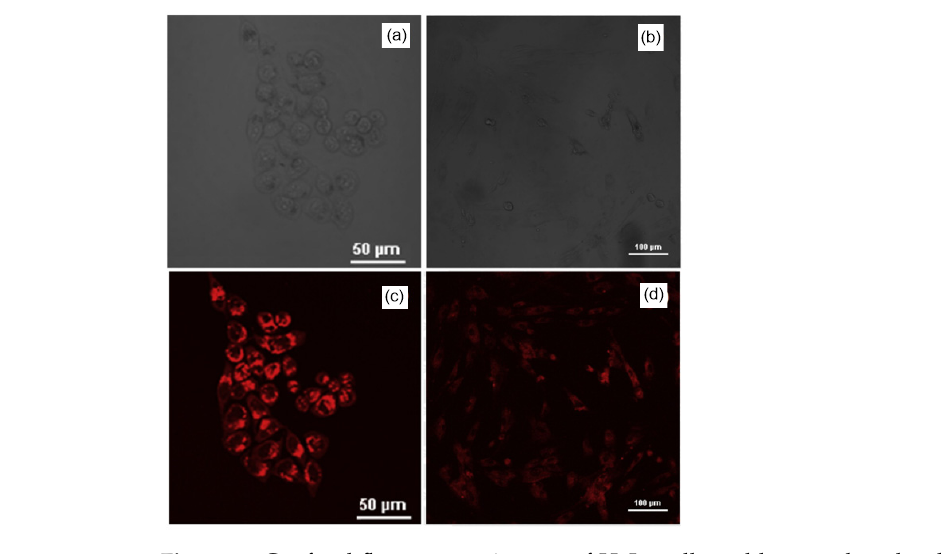
Figure 3. Confocal fluorescence images of HeLa cells and human dental pulp cells stained with BODIPY 2 . ( a , b ) Bright field image, ( c , d ) fluorescence images under a red channel (650 nm). Adapted from [20].